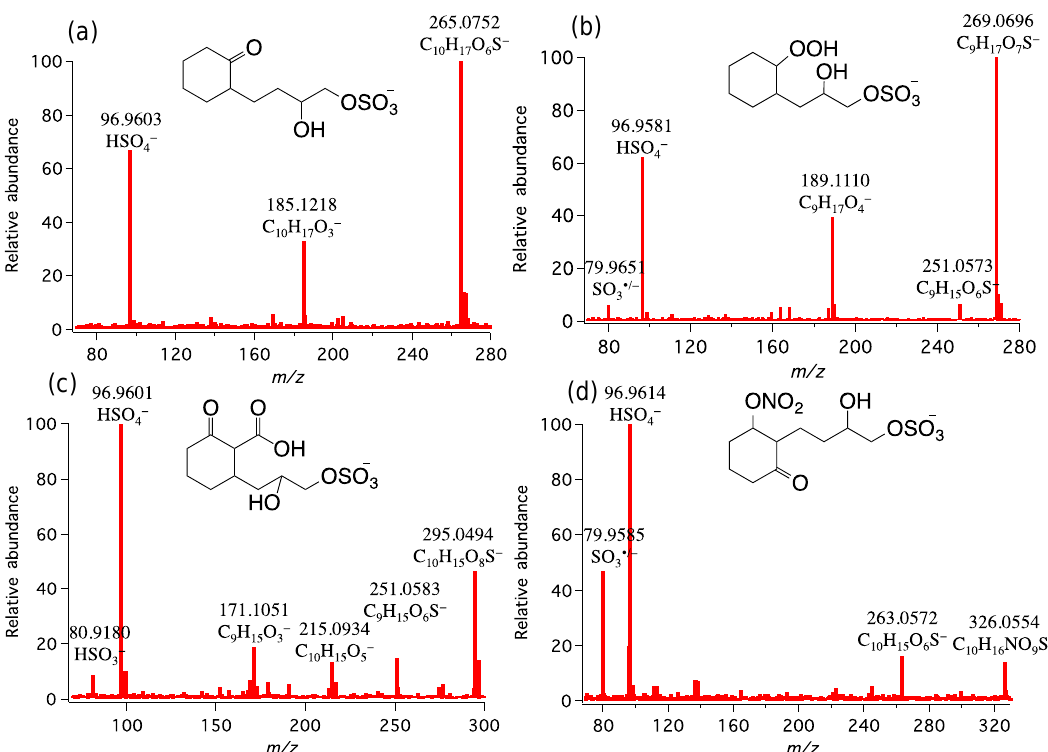
Figure 2. MS 2 spectra obtained for selected decalin-derived OSs: ( a ) m/z 265.0752 (C 10 H 17 O 6 S – ), ( b ) m/z 269.0696 (C 9 H 17 O 7 S – ), ( c ) m/z 295.0494 (C 10 H 15 O 8 S – ) and ( d ) m/z 326.0554 (C 10 H 16 NO 9 S – ). Fragmentation schemes are proposed in Figure S2.